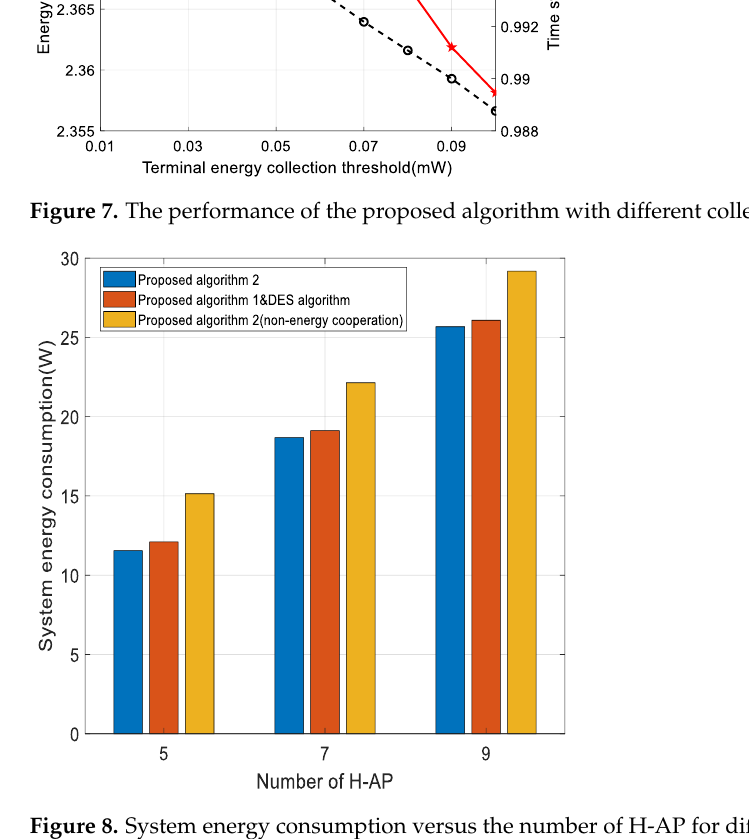
Figure 8. System energy consumption versus the number of H-AP for different algorithms.